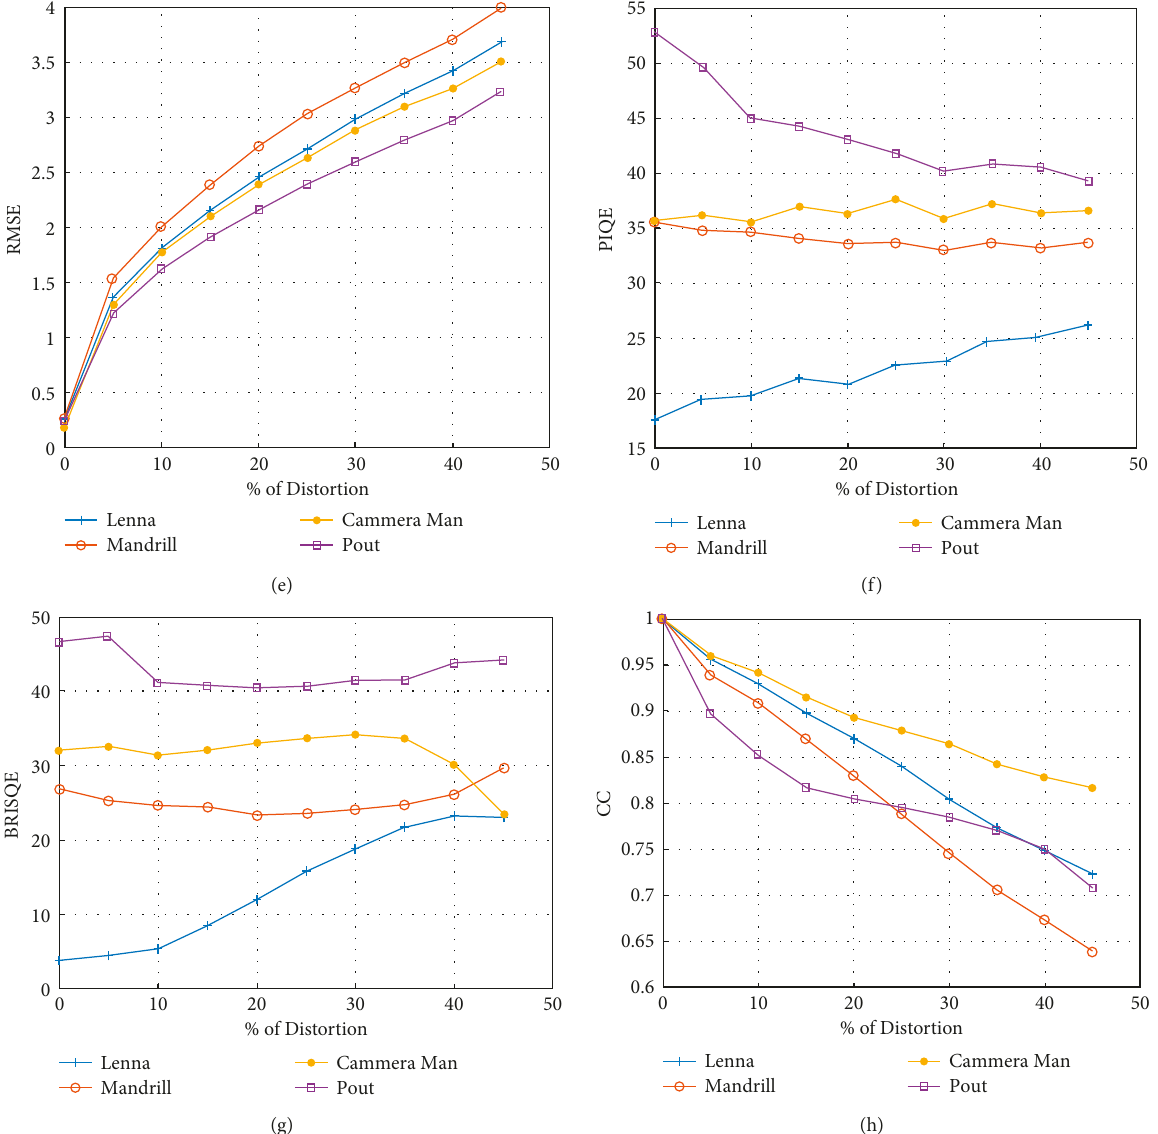
Figure 8: Performance comparison: (a) MSE, (b) PSNR, (c) SSIM, (d) MAE, (e) RMSE, (f) PIQE, (g) BRISQE, and (h) CC based on distortion.